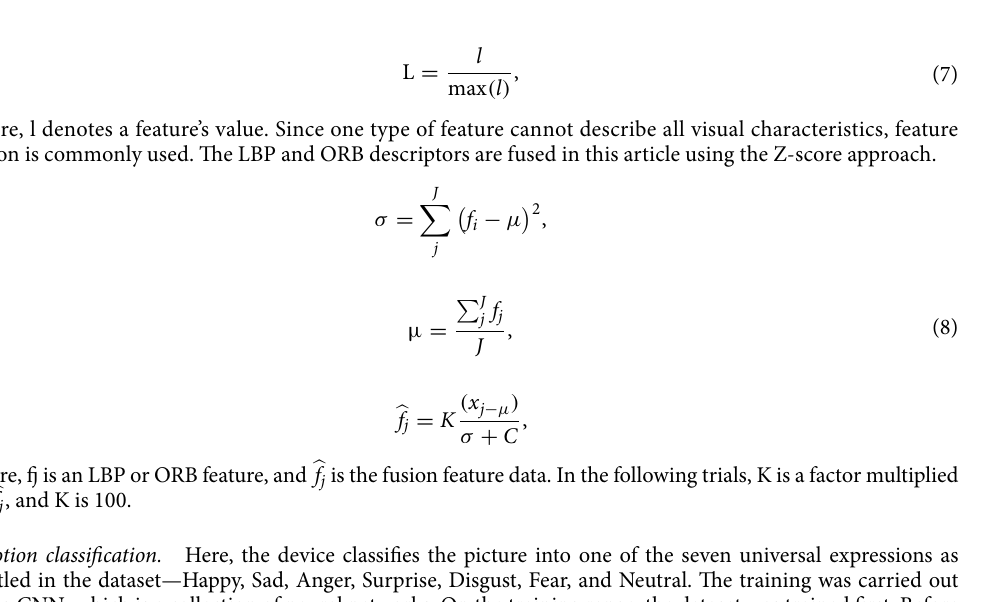
Table 1. Accuracy Comparison with related